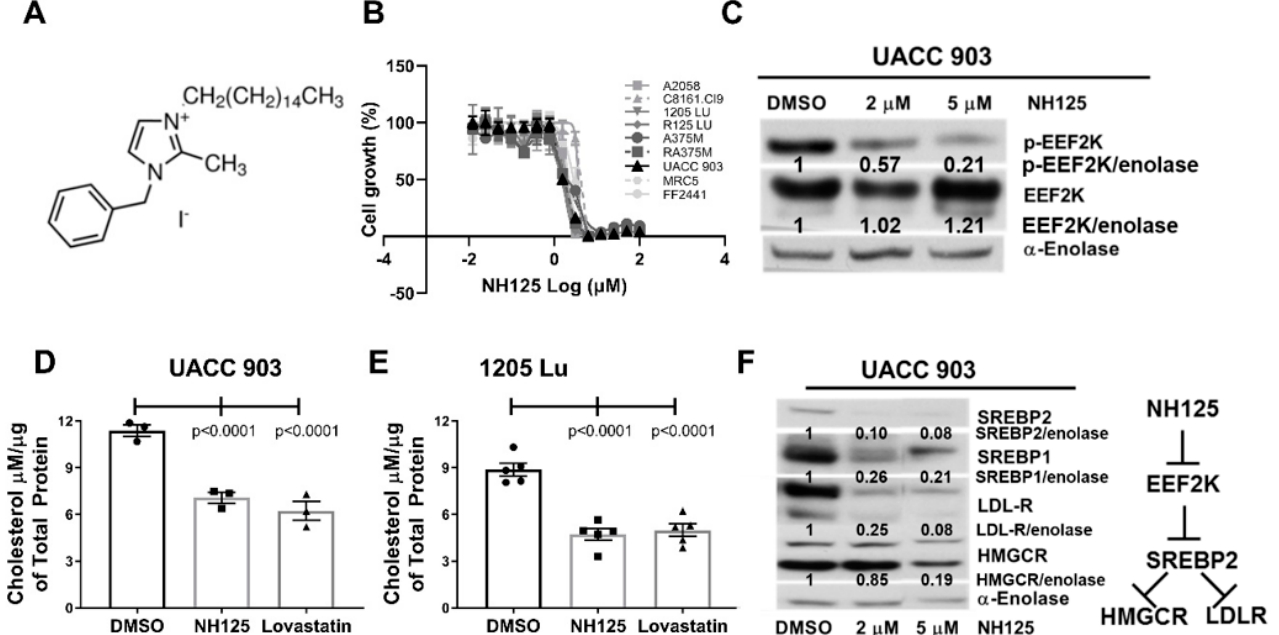
Figure 3. Pharmacological knockdown of EEF2K reduced cholesterol levels in melanoma. The pharmacological inhibitor of EEF2K, NH125 ( A ) significantly reduced the proliferation of melanoma cells after 72 h using an MTS assay ( B ) and decreased EEF2K phosphorylation ( C ) compared to total EEF2K levels. Alpha-enolase served as a protein loading control. Experiments were replicated three times. 5 µ M NH125 reduced the cholesterol levels in UACC 903 ( D ) and 1205 Lu ( E ) cells compared to control DMSO. Significance was measured by one-way ANOVA followed by Dunnett’s as the post-hoc analysis. Lovastatin treatment served as a positive control for the inhibition of cholesterol synthesis ( n = 3). Mechanistically, NH125 dose dependently lowered the LDLR, HMGCR, SREBP2 and SREBP1 levels in UACC 903 cells to reduce cholesterol levels ( F